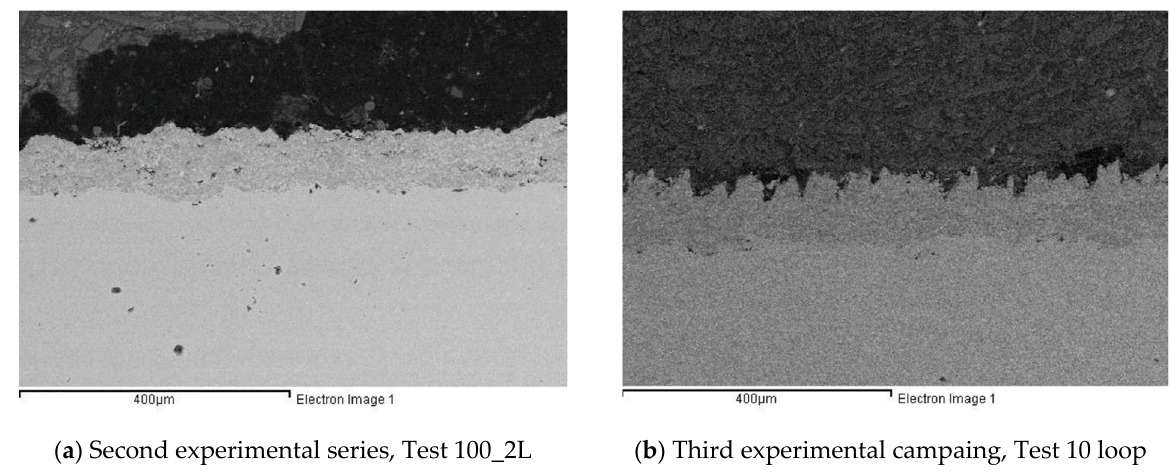
Figure 12. Sample cross section referring to laser polishing ( a ) and texturing ( b ) processes.